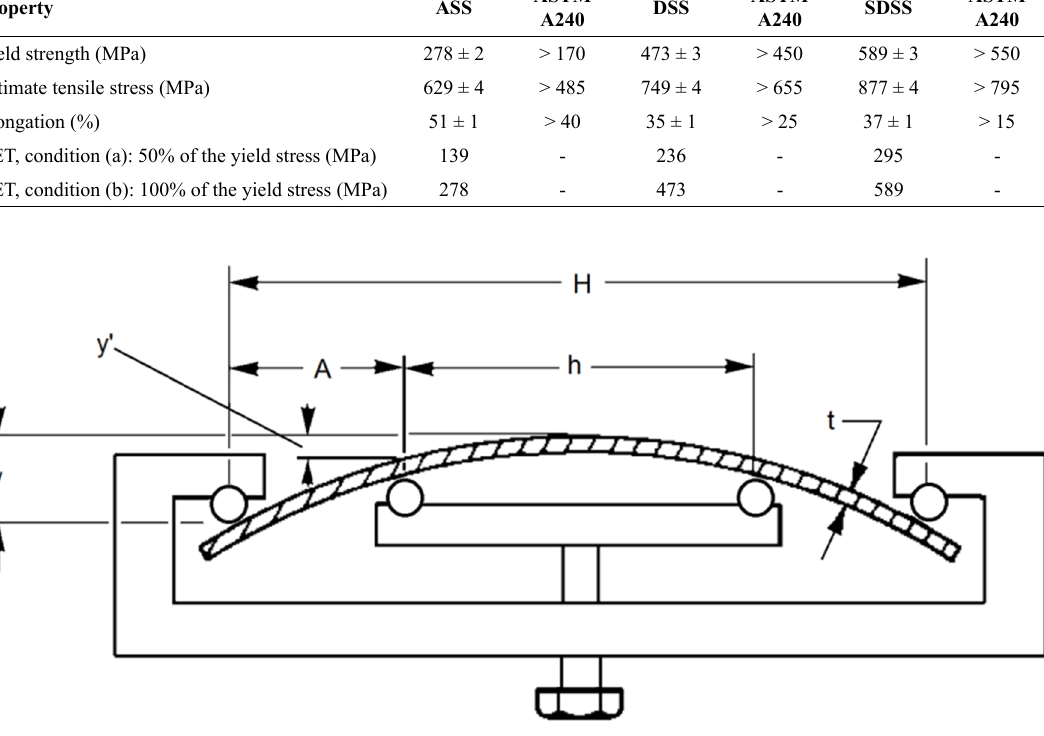
Figure 6. Schematic representation of the apparatus for mechanical loading (four-point bending) of the specimen and their geometrical parameters 37 . Table 4. Saline concentration of synthetic sea water according to ASTM D1141 38-39 .